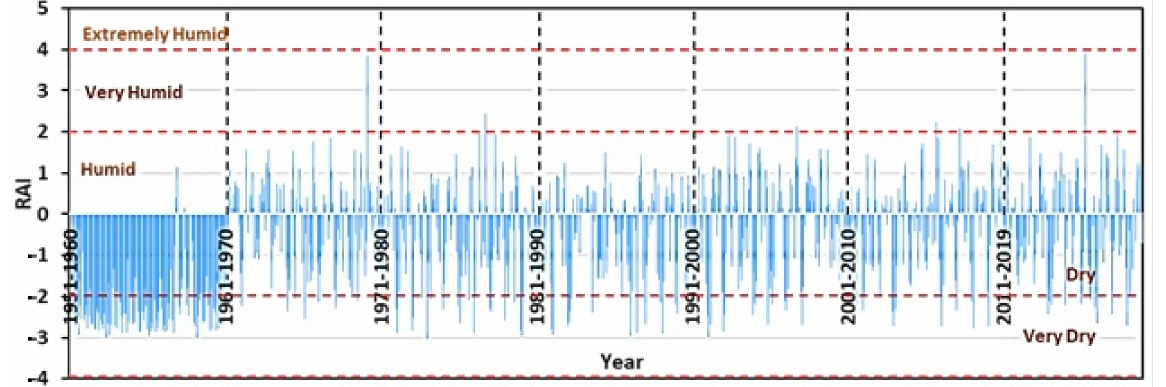
Figure 3. Temporal variability of monthly rainfall anomalies from 1951 to 2019. The figure is shown for the RAI classification as wet and dry. Positive anomalies have appeared in the wet months and negative rainfall anomalies have appeared in the dry months during the study